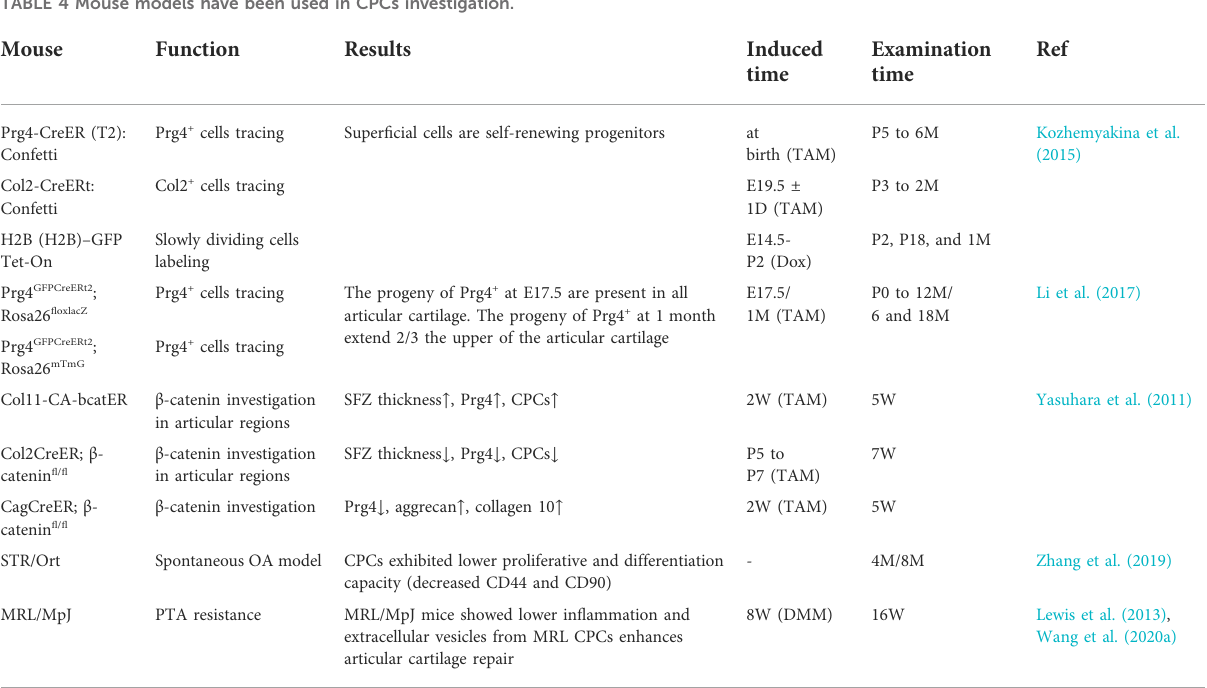
TABLE 4 Mouse models have been used in CPCs